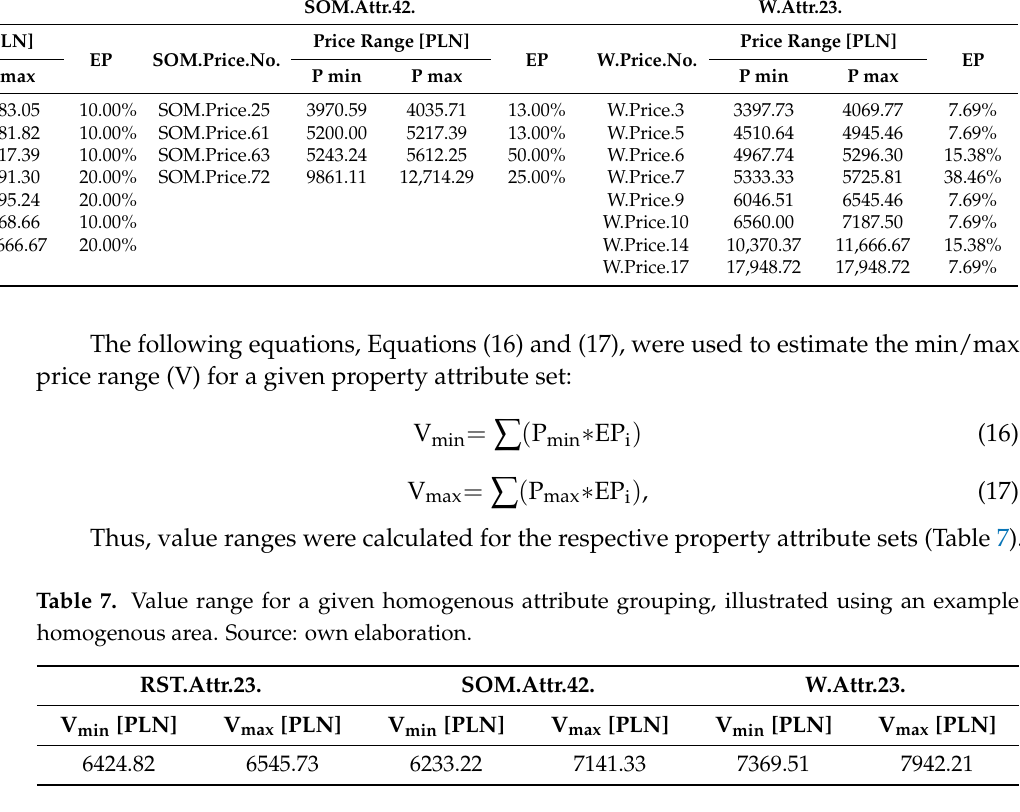
Table 6. Empirical probability of a given homogenous attribute grouping occurring within the different price groups, illustrated using an example homogenous area. Source: own elaboration. RST.Attr.23. SOM.Attr.42. W.Attr.23.